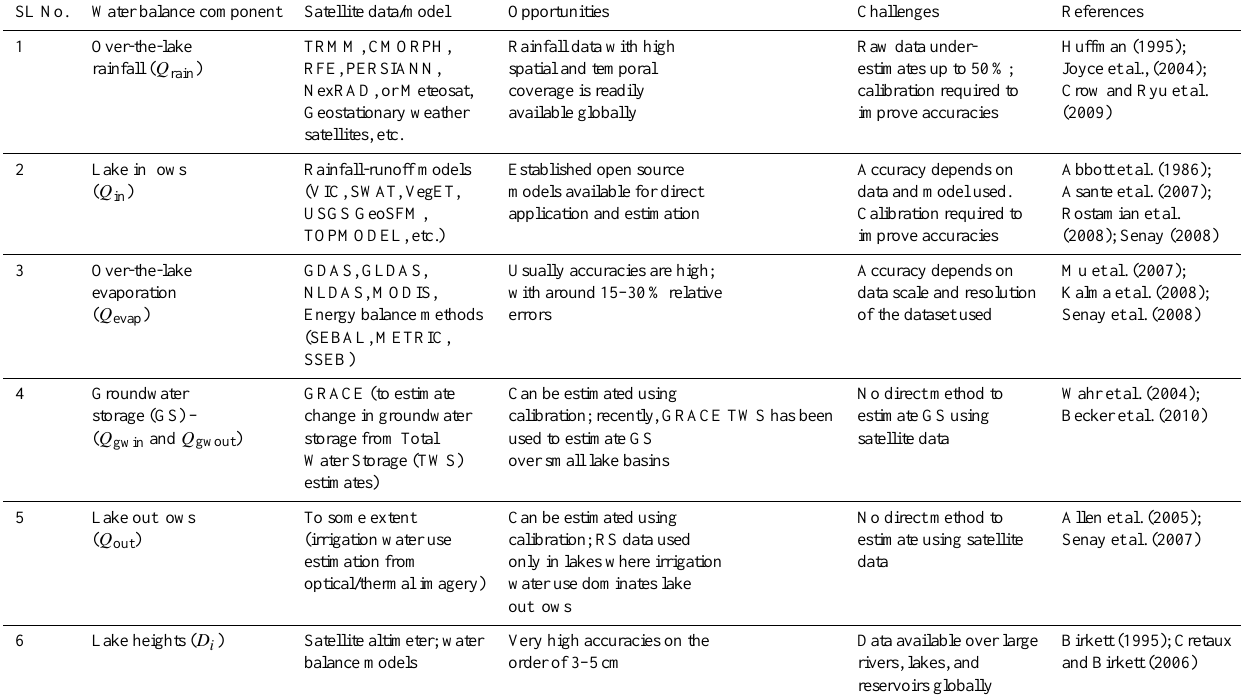
Table 1. Challenges and opportunities of using satellite data for estimating components of lake water balance in data limited regions. SL No. Water balance component Satellite